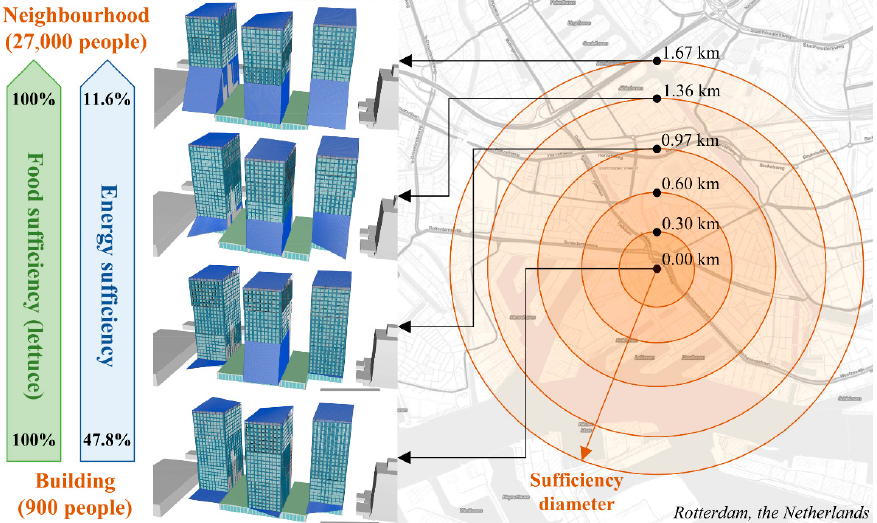
Figure 25. Sufficiency diameter of Europoint complex in Rotterdam, the Netherlands.